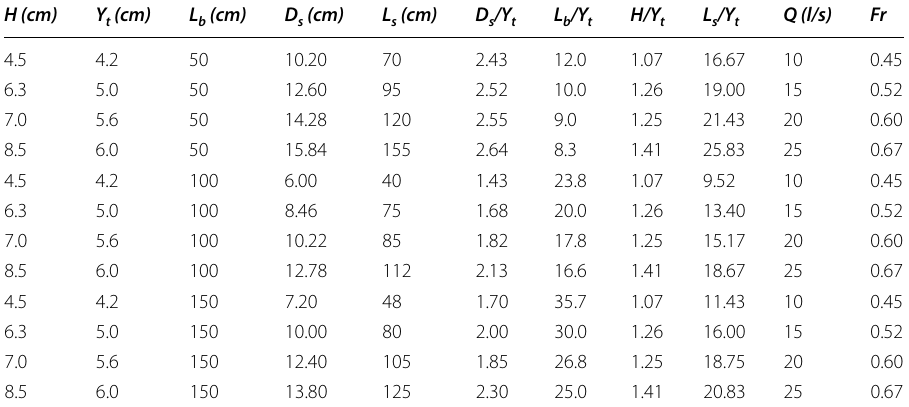
Table 1 The laboratory measurements as well as scour hole depth and length calculation of a sharp-crested weir at apron solid lengths 50, 100, and 150 cm for weir heights 25 cm